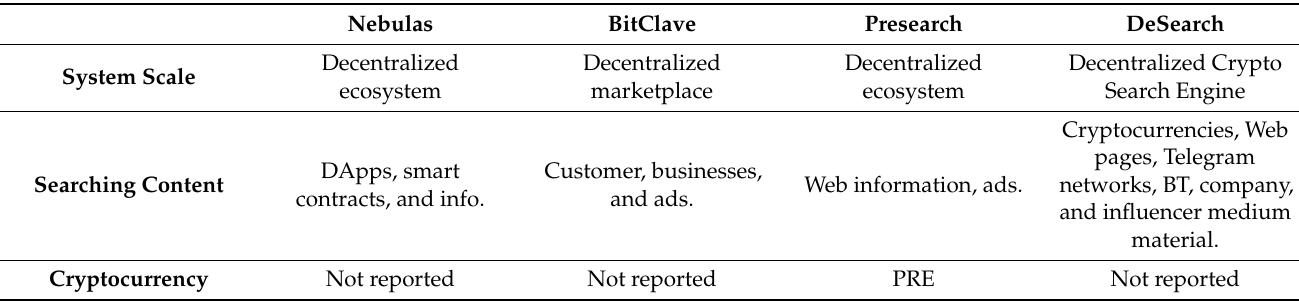
Table 2. Comparison of existing blockchain-based search engines. Nebulas BitClave Presearch DeSearch Decentralized Decentralized Decentralized System Scale